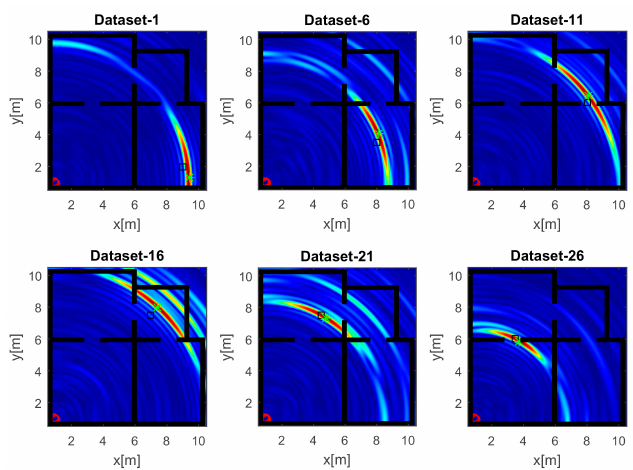
Figure 10. Tomographic images of a UWB source achieved with the tilted array (B). Array (red circles); true source position (black square); estimated source position (green asterisk). Color scale is [0, 1].